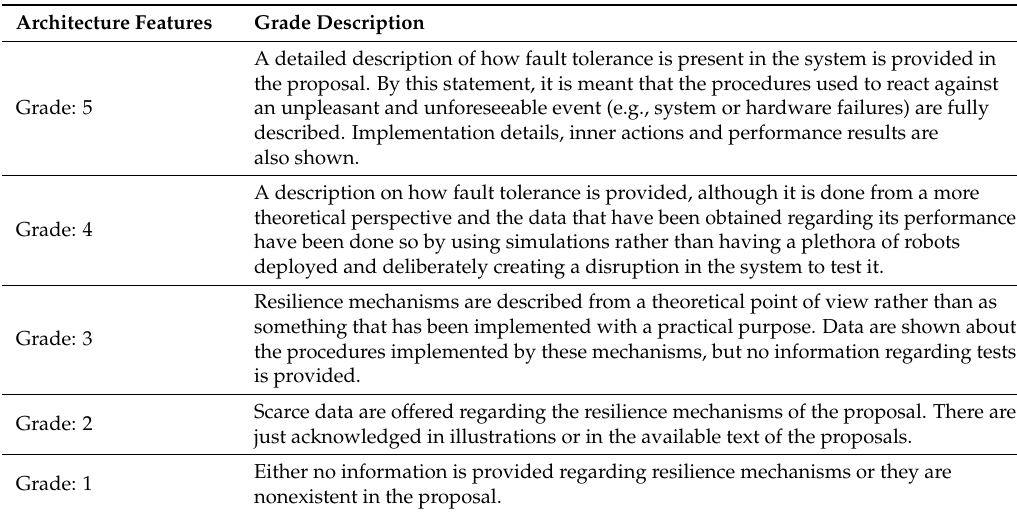
Table 5. Fault tolerance